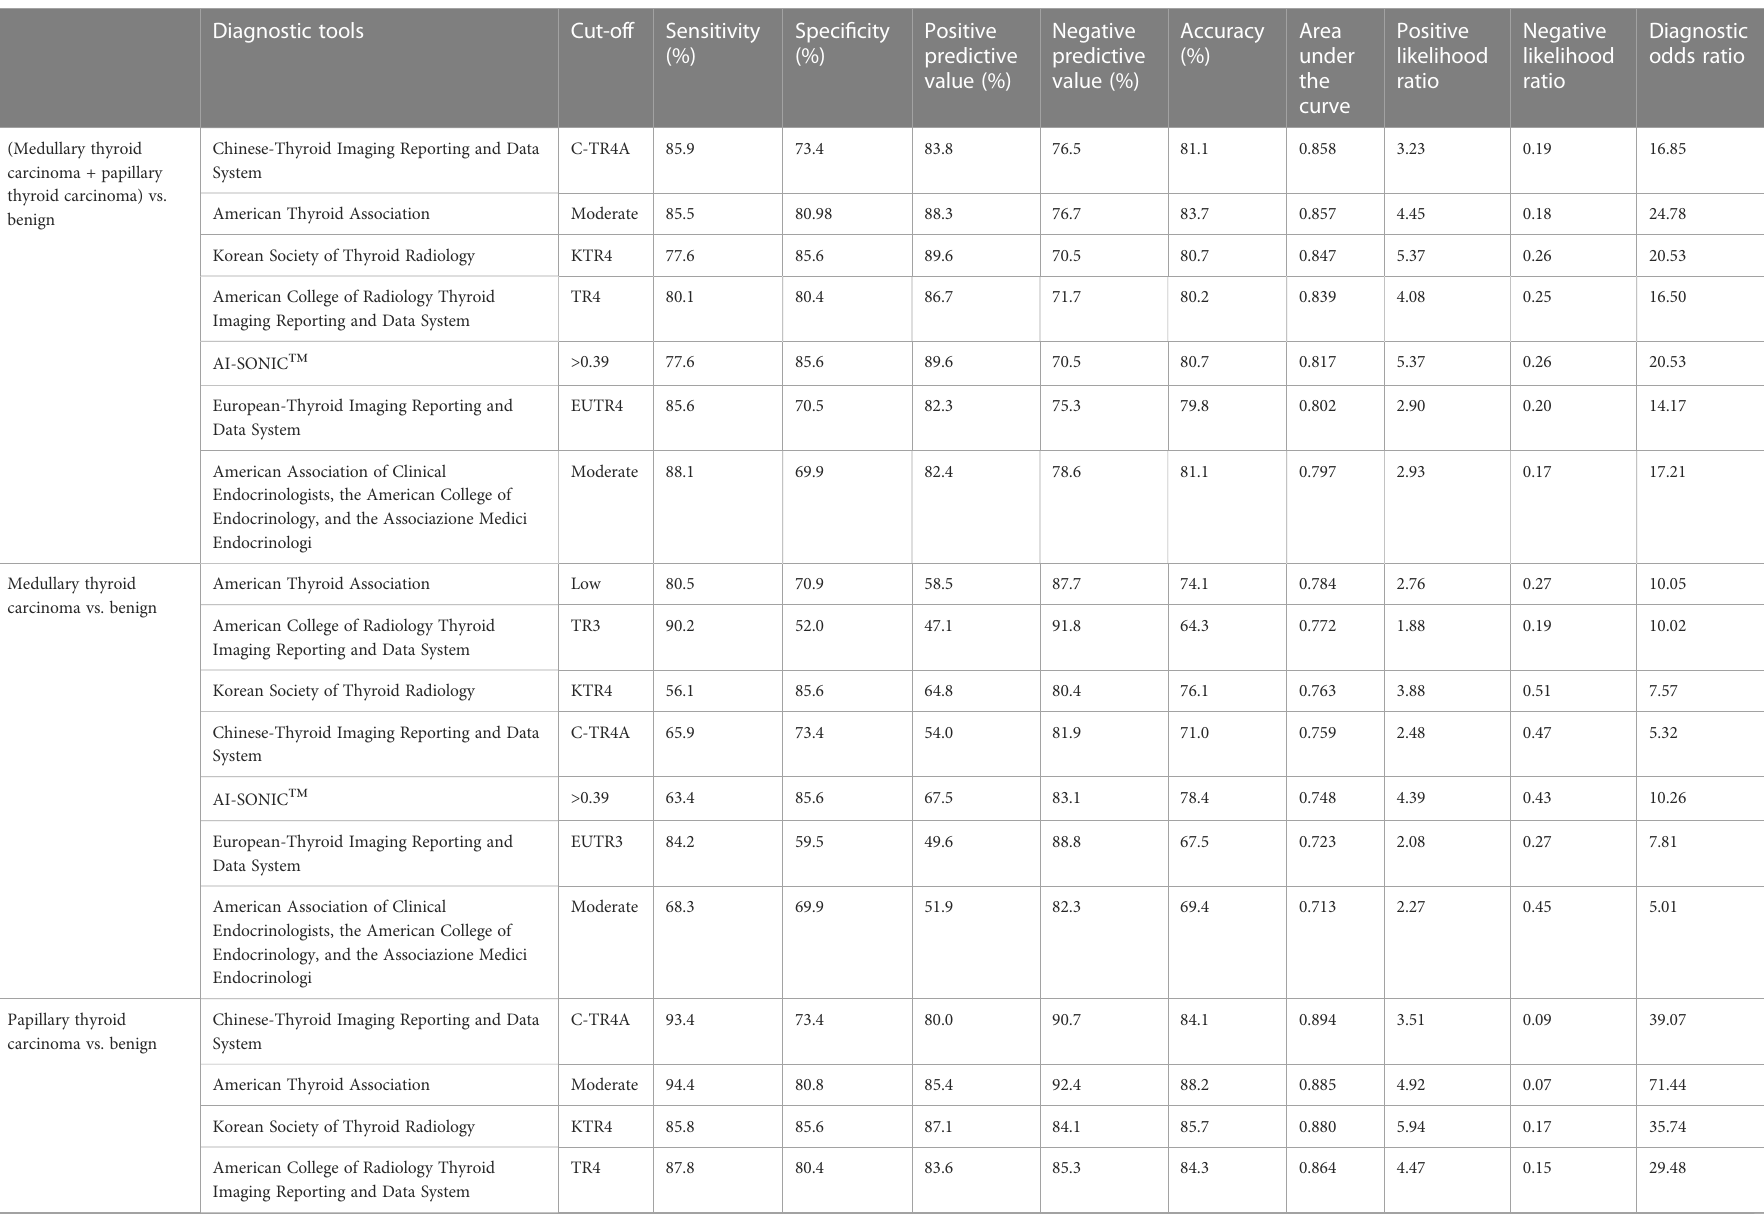
TABLE 3 Diagnostic ef fi ciency of the six guidelines and AI system.